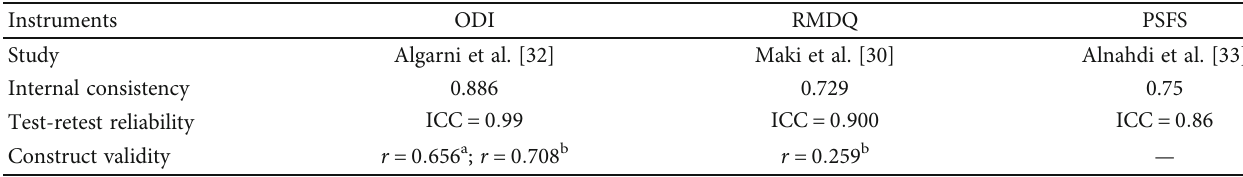
Table 1: Psychometric properties of Arabic instruments used in this